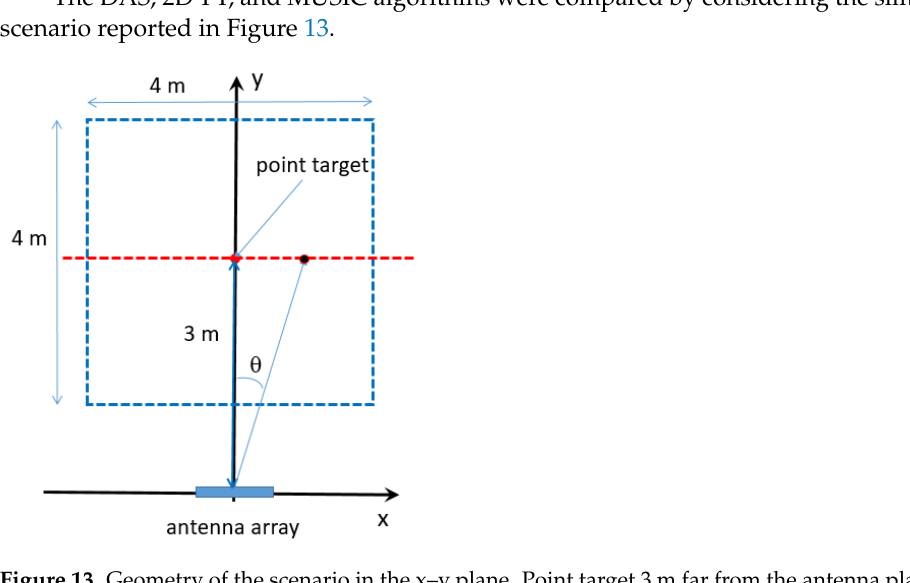
Figure 12. Cross-range cuts of the normalized intensity function for the 4 antennas and 16 antenna cases: ( a ) f 0 = 2 GHz, FBW = 0.1; ( b ) f 0 = 24 GHz, FBW = 0.1.